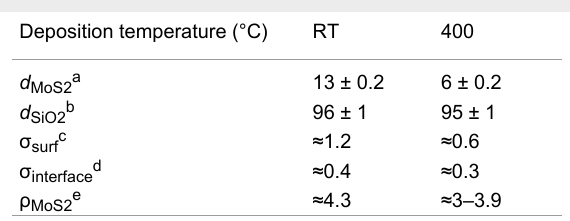
Table 1: Thickness, roughness and density of MoS 2 films deposited at RT and 400 °C on thermally oxidized Si/SiO 2 wafer, determined from fitting of the XRR